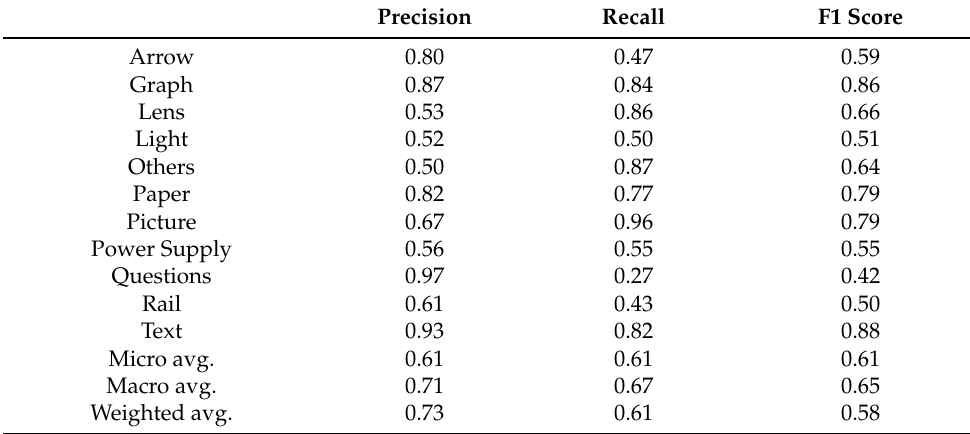
Figure 7. Confusion matrix for YOLO v4 with interpolation. Table 1. Confusion Report for YOLO v4 without